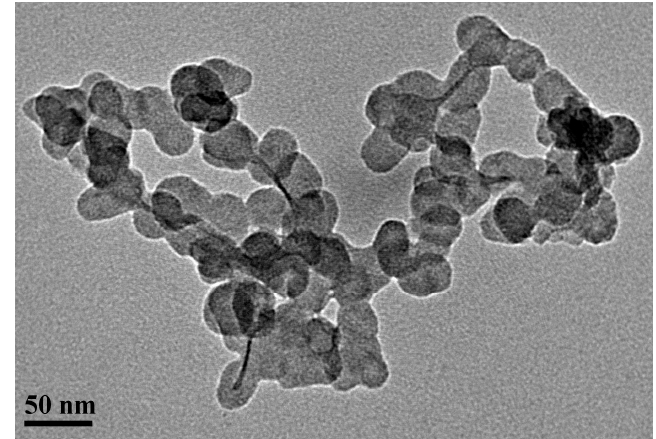
Figure 2. Size and morphology of CuZn NPs determined by transmission electron microscopy.